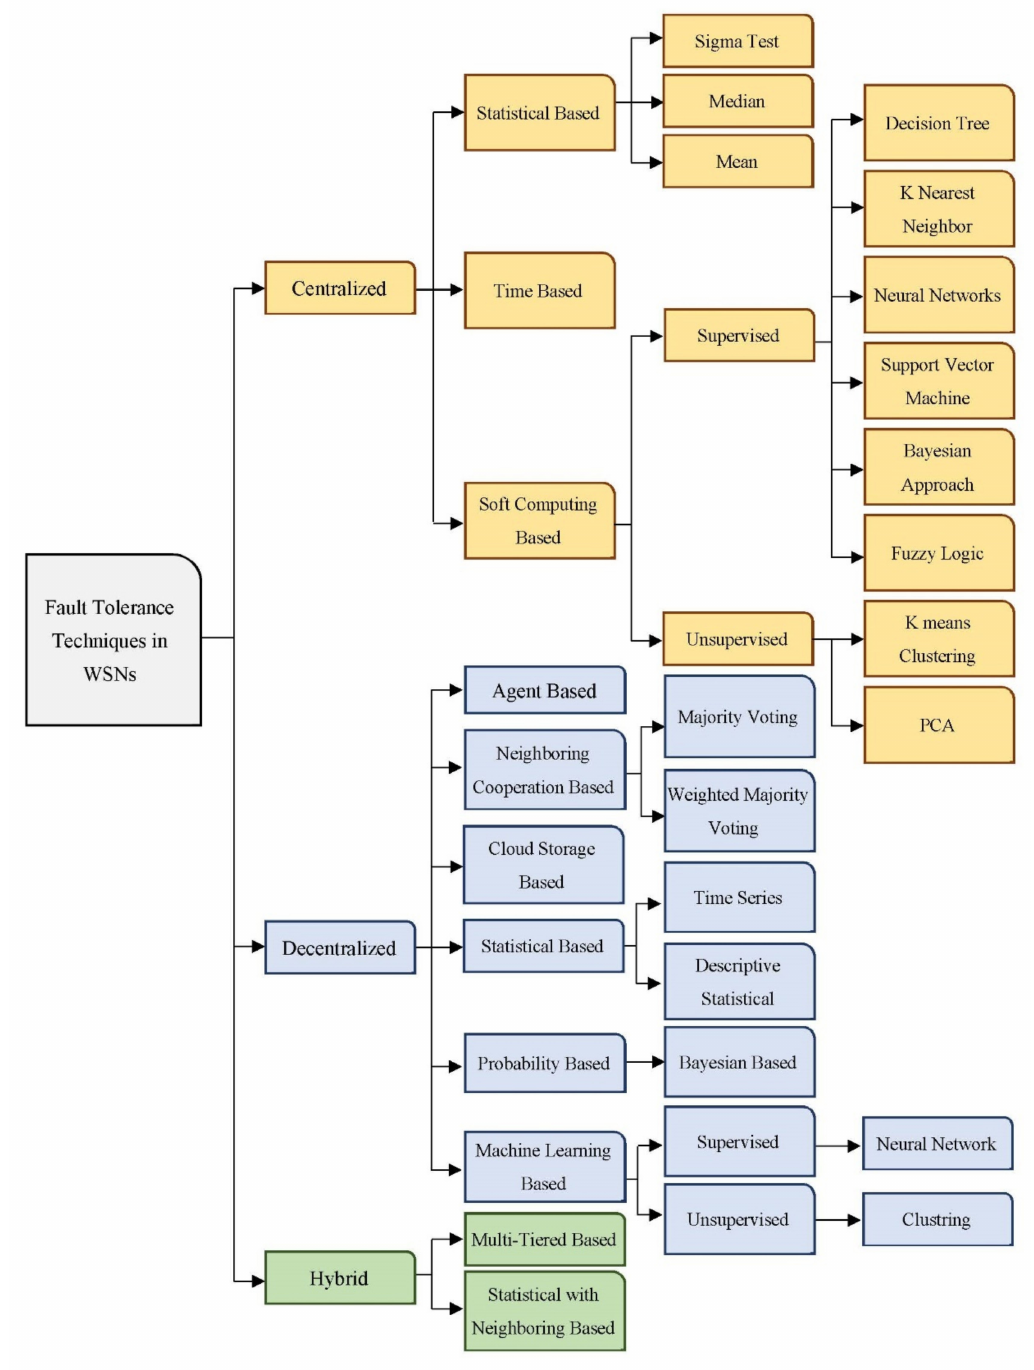
Figure 3. General taxonomy of fault tolerance approaches in